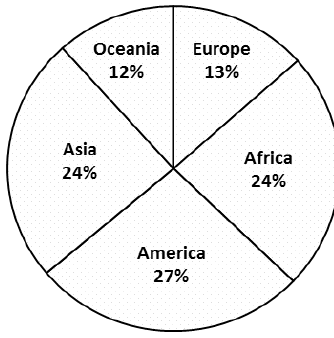
Figure 1: Ilmenite ore processing worldwide in 2011 [3], with the American continent being the single largest source